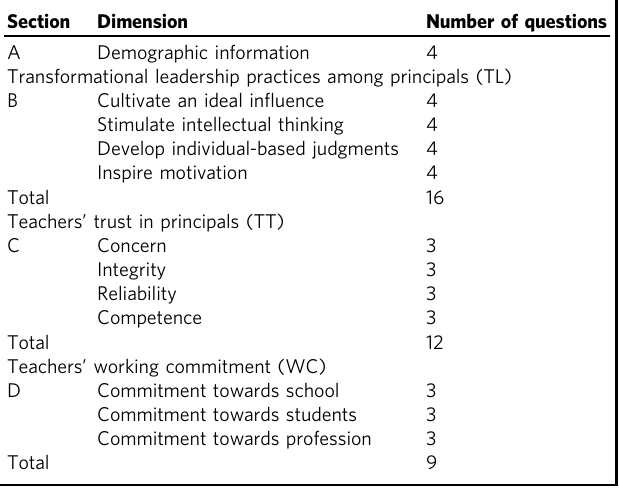
Table 2 Summary of the survey questionnaire.